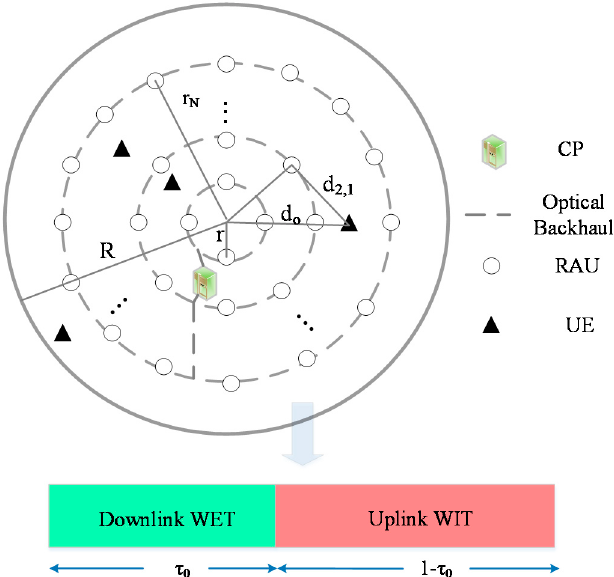
Figure 1. The system model of wireless-powered based massive distributed antenna system.